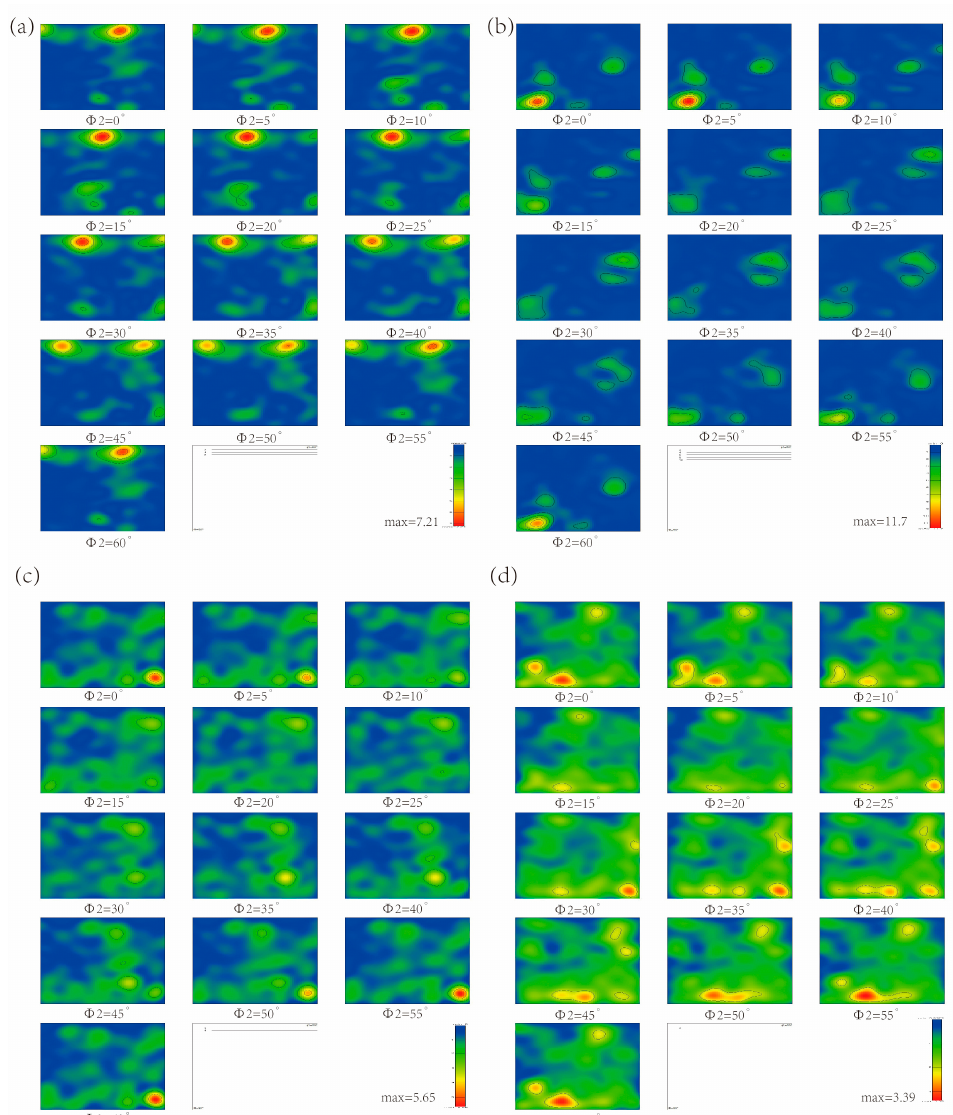
Figure 16. ODF image of TC4 alloy after MDIF: ( a ) one cycle; ( b ) two cycles; ( c ) three cycles; ( d ) four cycles.